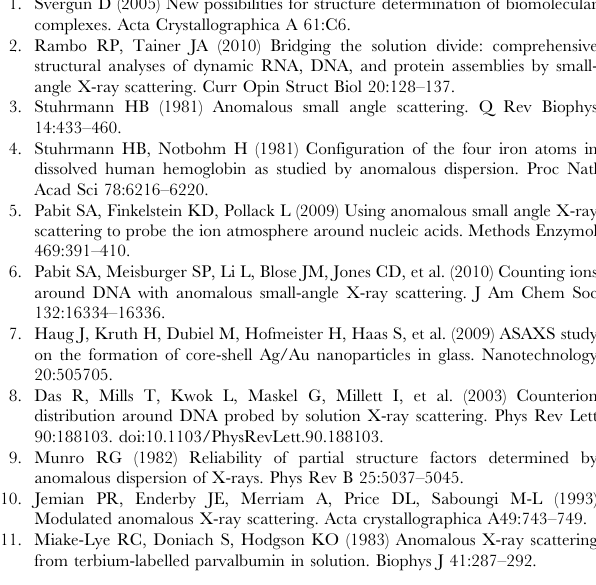
Figure S1 Partial structure factor . Gold nanocrystal partial structure factor G s ð Þ for a 50 base-pair DNA molecule before truncation and baseline shifting. The oscillatory nature of the function is clear at small s values, but an increase in the contribution of random errors can be seen as s increases. This data was truncated at s max ~ 0 : 04 A˚ 2 1 where the oscillations are almost indistinguishable from the noise. Programs S1 MATLAB codes. A zipped file containing the MATLAB code files used in this work. The code runs through